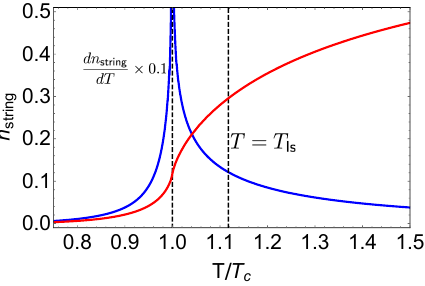
[ Eq. 45 ] calculated from | ε | [ Eq. 60 ] in the unconstrained Figure 20: The density of strings, n string k manifold (red). The parameters used are J 1A = 1 and J 1B = 1.5. Also shown are the value of T Is (black, dashed line) and dn string / dT (blue), which shows a logarithmic divergence at T = T c